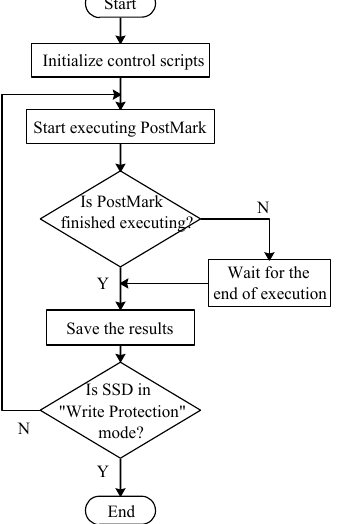
Figure 4. The auto-execution procedure of PostMark in the measurement